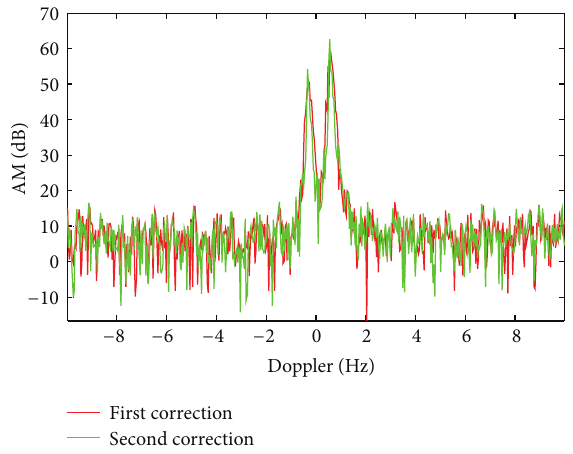
Figure 8: The secondary decontamination results using